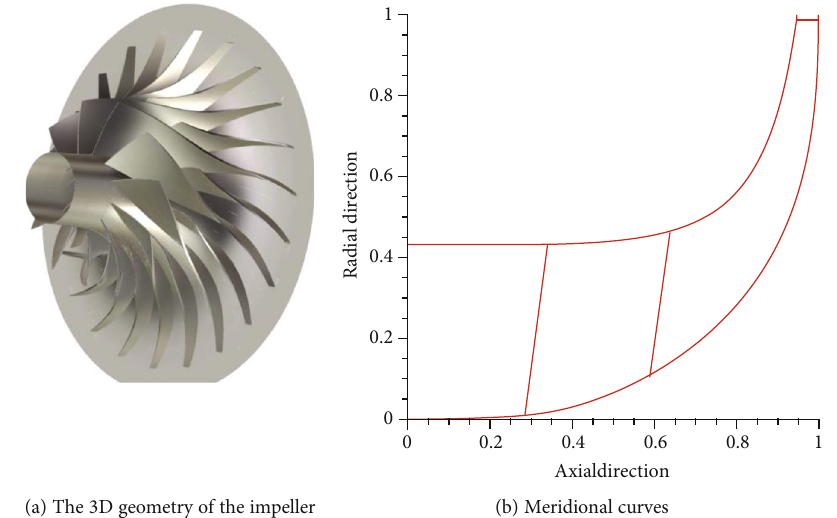
Figure 2: Impeller geometry structure.